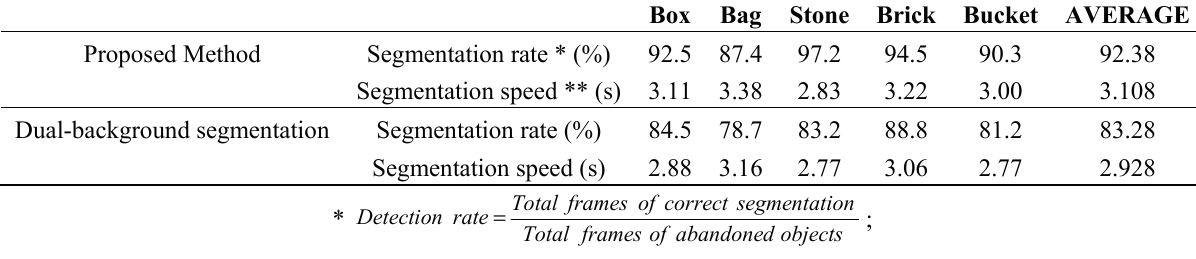
Table 1. Average abandoned object segmentation performance. Box Bag Stone